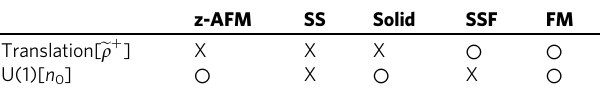
z-antiferromagnetic, spin supersolid, spin super fl uid, and ferromagnetic phases are abbreviated into z-AFM, SS, SSF, and FM separately. ○ indicates the symmetry is present and X indicates it is broken. Orders that appear after translation and U(1) symmetry breaking are also indicated in the brackets and their de fi nitions come from Eqs. (7) and (8). Notice that the translational symmetry breaking denotes the appearance of spatial inhomogeneity in the triplon density, while the U(1) symmetry breaking indicates the condensation of the S z =+ 1 triplon. z-AFM and SolidbothpossessU(1)symmetrybuthavedifferentquantumnumbers S z :zeroforz-AFMwhile 0.5 for Solid. It is clear to see from the symmetry that a fi rst-order transition takes place at the phase boundary between Solid and SSF, where phases break distinct symmetries on different